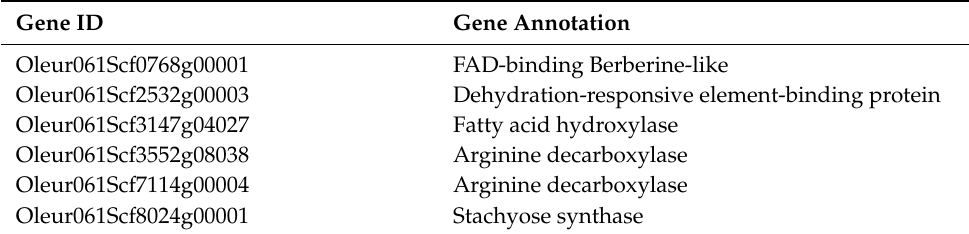
Table 4. Use case example genes and their putative annotations.